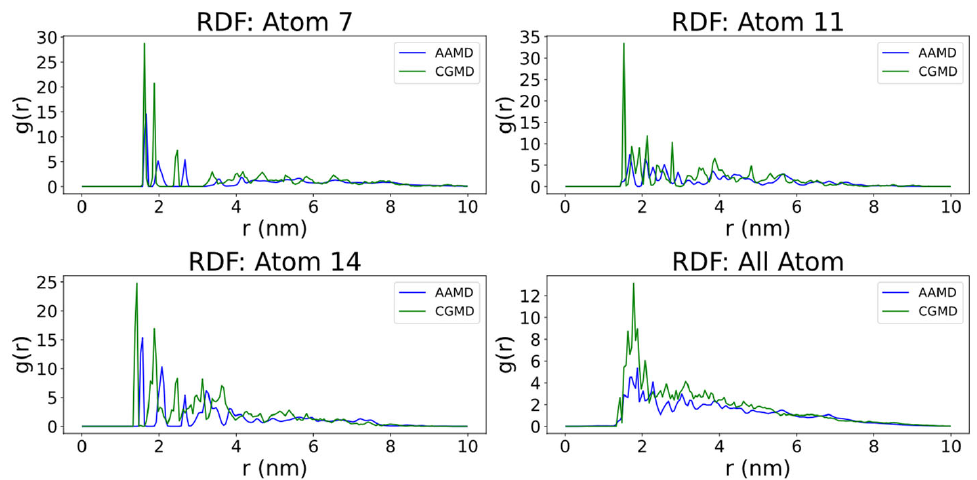
Figure 9. RDF plot from single reference atom comparison of the solvated CGMD simulations vs. the solvated AAMD validation simulations. “Atom 7” and “Atom 14” reflect on the NTD, and “Atom 11” reflects the receptor-binding domain.